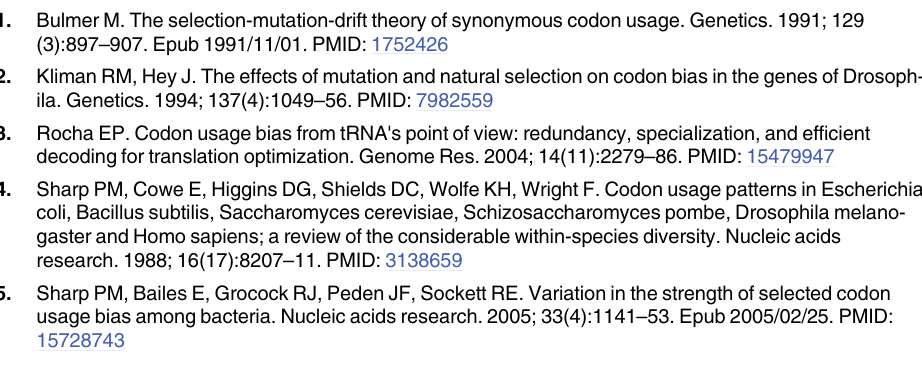
S1 Fig. Selective disadvantages of synonymous tuf alleles. Boxplots of selective disadvantages for tufA and synonymous tuf alleles. Whiskers indicate interquartile ranges. S2 Fig. Distribution of selection coefficients in competition experiments. Histogram of the selection coefficients from 168 measurements of a strain with a tufA gene in both tuf loci. Mea- surements that follow a normal distribution are shown in red and outliers in blue. S1 Table. Codon usage of relevant codons in synonymous tuf alleles a . a The first forty codons were excluded to reduce the impact N-terminal codon bias. All differences between the synony- mous tuf alleles and tufA are shown in bold. S2 Table. Codon usage in the tufA gene a . a The first forty codons were excluded to reduce the impact N-terminal codon bias. S3 Table. Overview over tRNA dosage a . a Intracellular concentration of tRNA ( μ M) in E . coli K12 with a growth rate of 2.5 doublings per hour